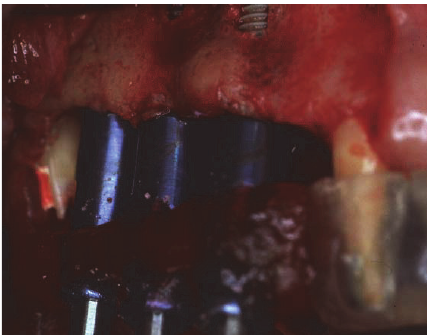
Figure 20: At the time of the insertion, buccal fenestration appeared on implant 14 that required an autologous bone chips graft covered by a resorbable collagen membrane (Biomend).